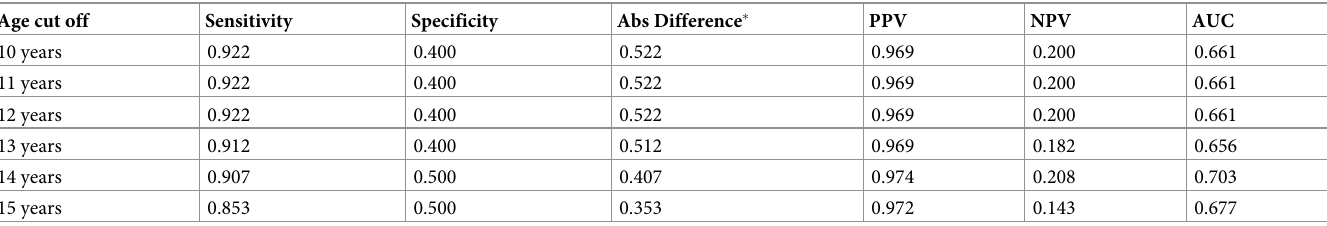
Table 6. Calculation of optimal cut-off age through validation against logic tree determination for the additional young mothers. Age cut off